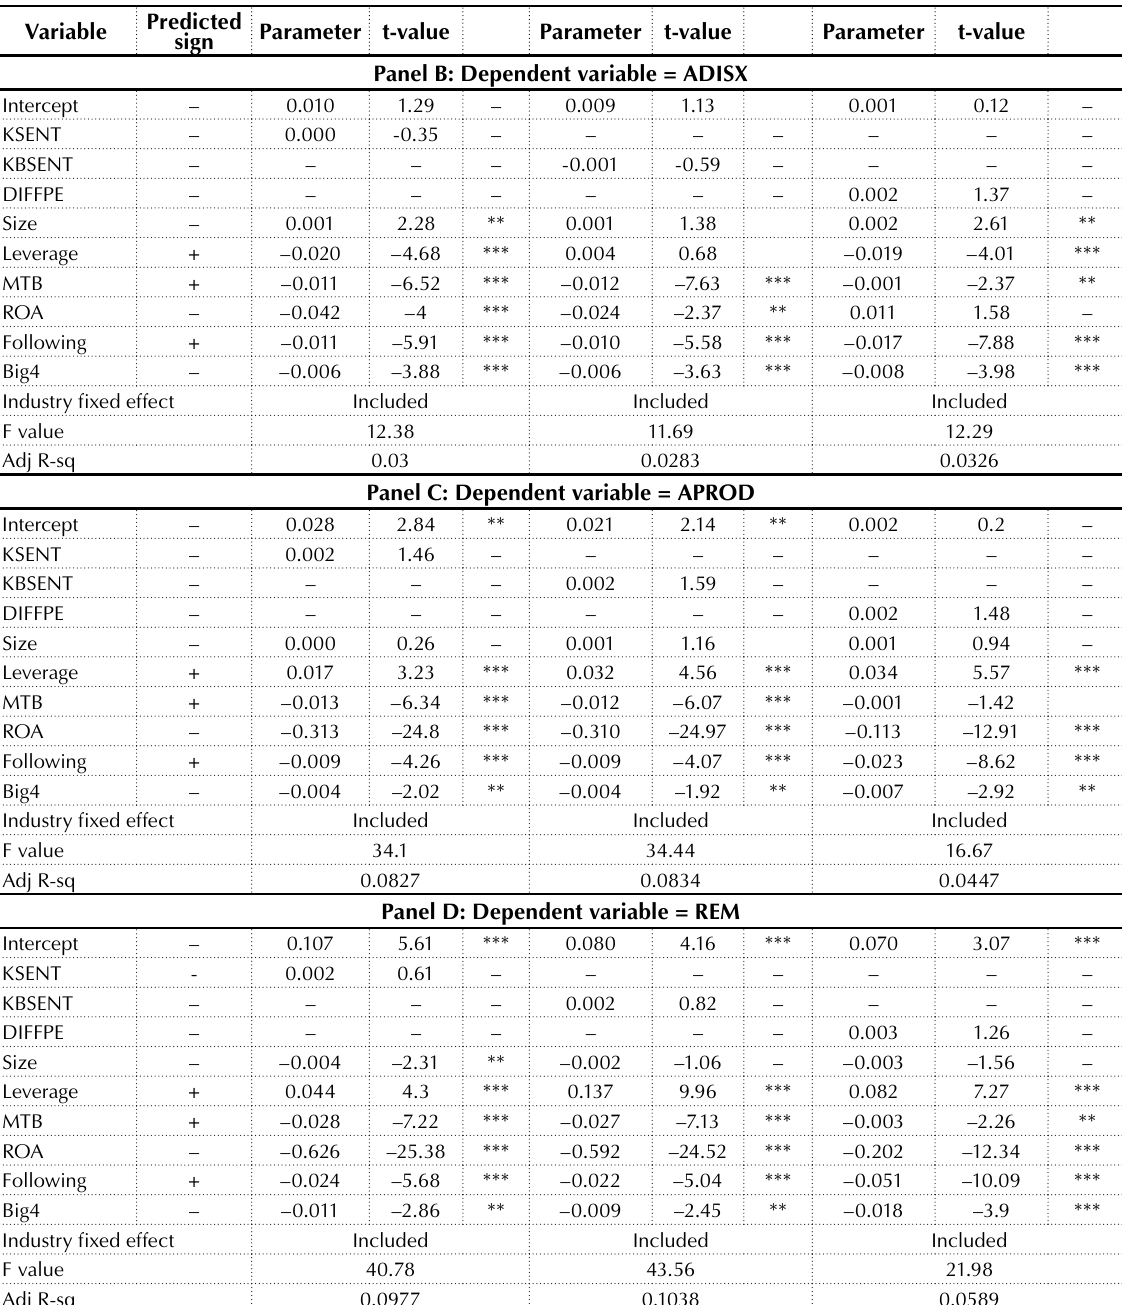
Table 4 (cont). Investor sentiment and real-based earnings